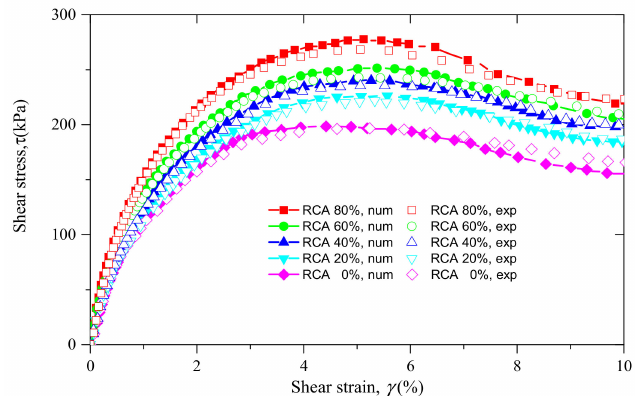
Figure 8. The curves of shear stress versus shear strain of the experimental samples and the numerical models with various RCA contents under the confining stress of 200 kPa.